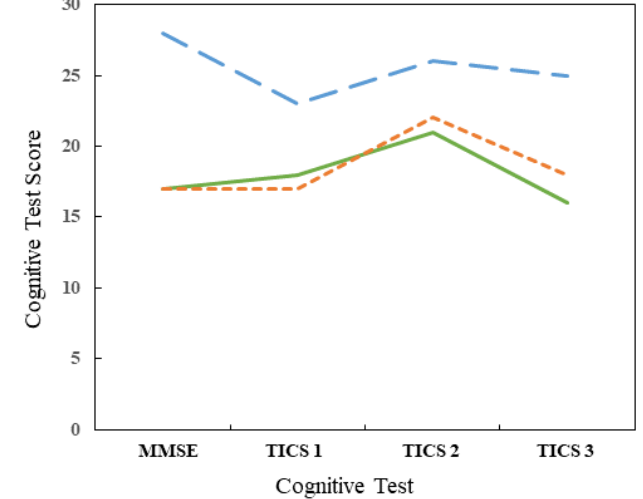
Figure 4. Cognitive test scores in the 3 participants with medication changes. The MMSE was completed at the baseline study visit. The Telephone Interview for Cognitive Status were completed over the phone after a change in medication and subsequently at 6 and 12 weeks. MMSE: Mini-Mental State Examination; TICS: Telephone Interview for Cognitive